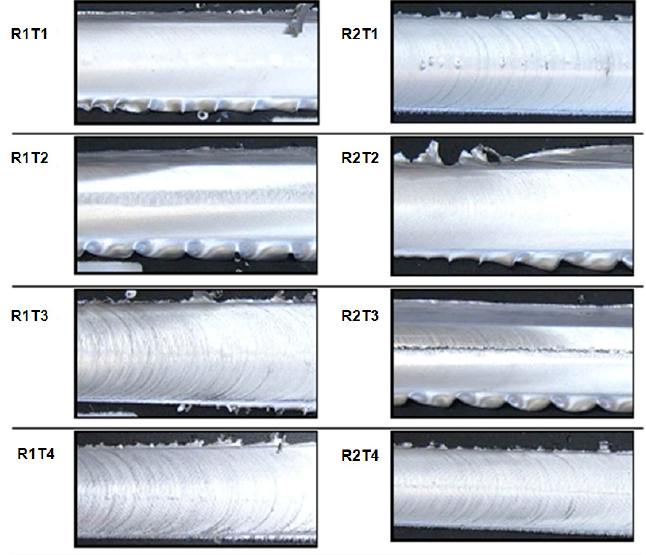
Figure 8. Visual examination of the surface of joints.